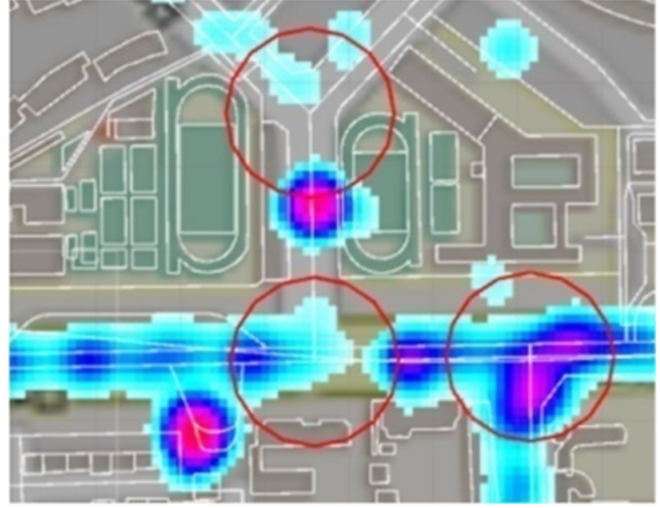
Figure 2. Kernel density estimation of stay-points. The red circles are regions with road